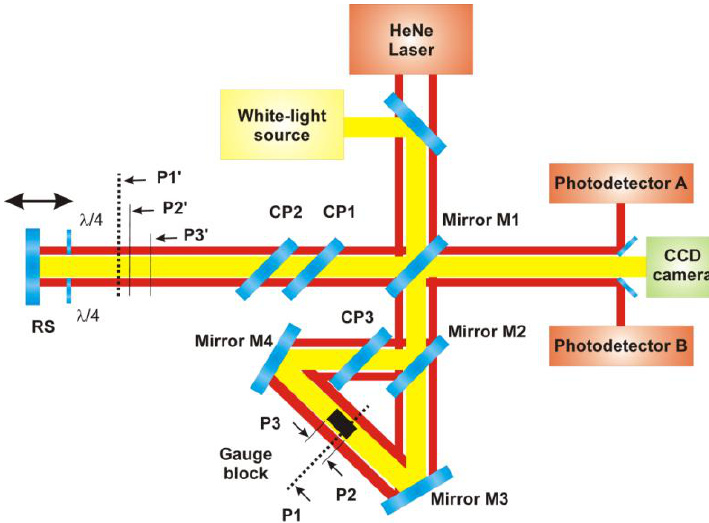
Figure 1. Optical setup for gauge blocks measurement. CP1, CP2 and CP3 are compensating plates and RS is a reference